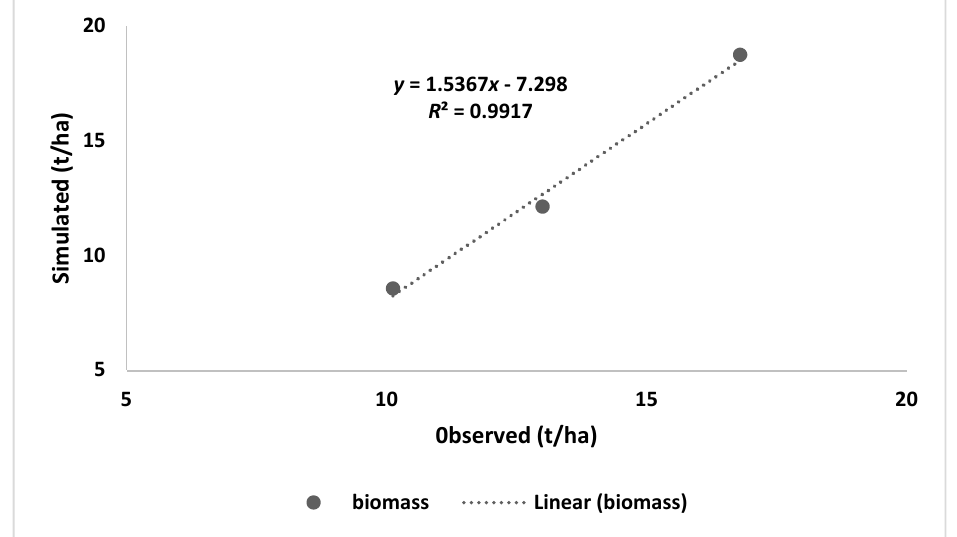
Figure 1. Simulated vs. measured final aboveground biomass values for all the three growing seasons.